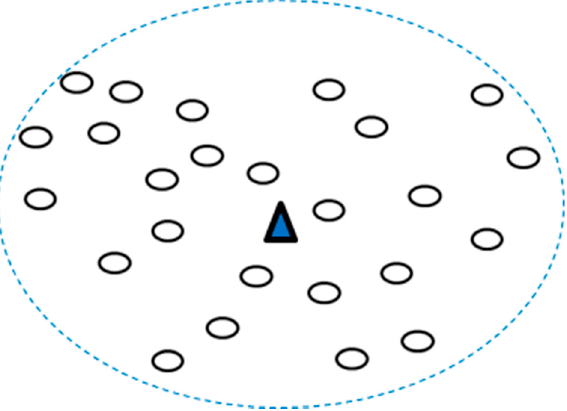
Figure 2. Coverage of all SMs in the area under study with one DAP (the triangle symbol), K = 1.